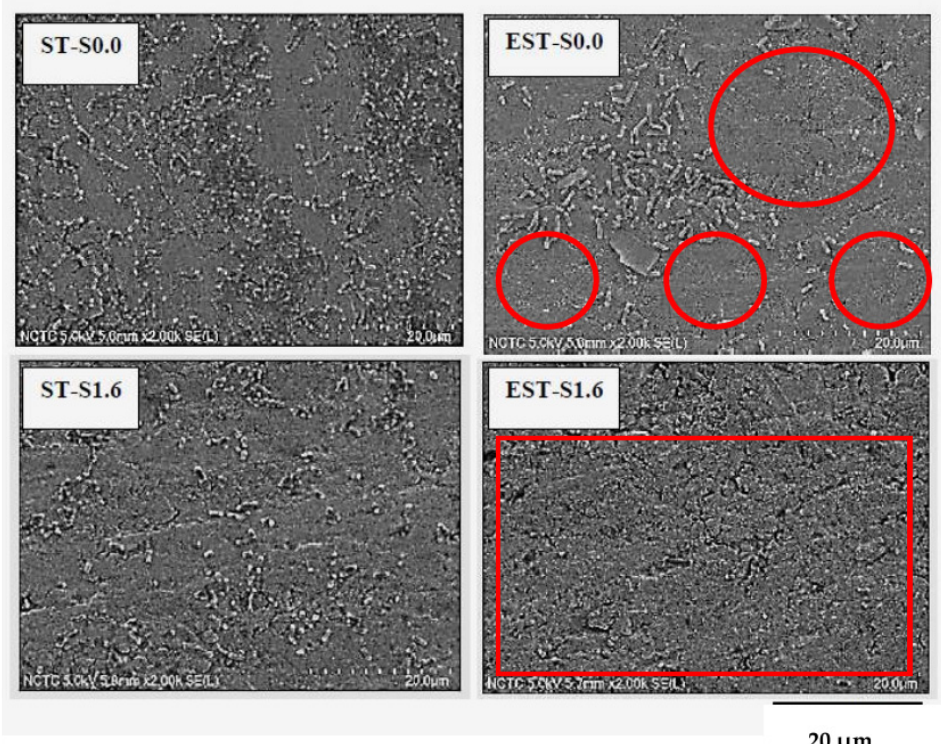
Figure 4. Morphology of biofilm-contaminated titanium surface under conditions with non-ionic and non-electrical treatment (ST-S0.0) in comparison to those with electrical treatment (EST-S0.0), ionic silver 1.6 µg/mL without electrical treatment (ST-S1.6), and ionic silver 1.6 µg/mL with electrical treatment (EST-S1.6).